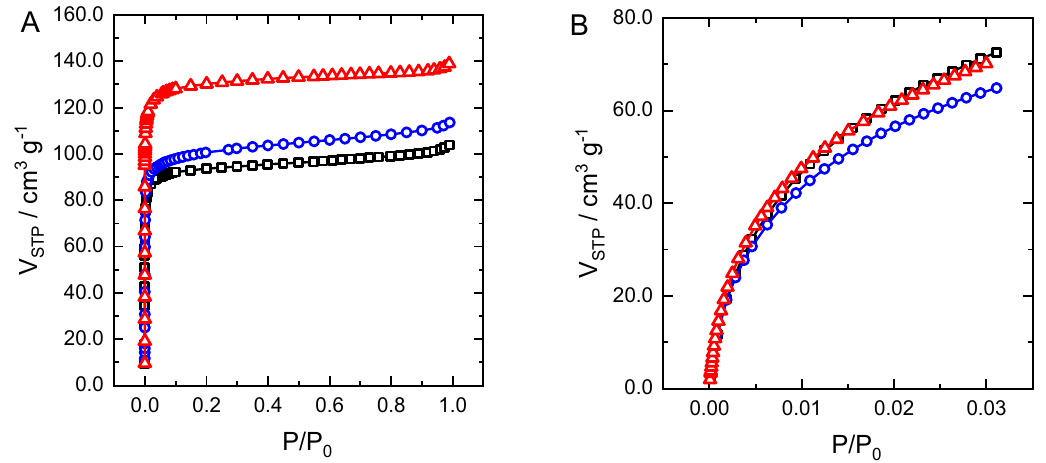
Figure 2. ( A ) Nitrogen adsorption isotherms at − 196 ◦ C, and ( B ) carbon dioxide adsorption isotherms at 0 ◦ C for samples SucNaCl0.80 ( (cid:3) ), SucNaCl1.00